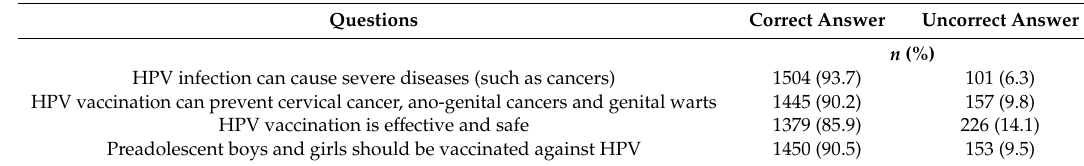
Table 4. Knowledge of students enrolled in the study regarding HPV infection and vaccination in the post-intervention questionnaire ( n = 1605).